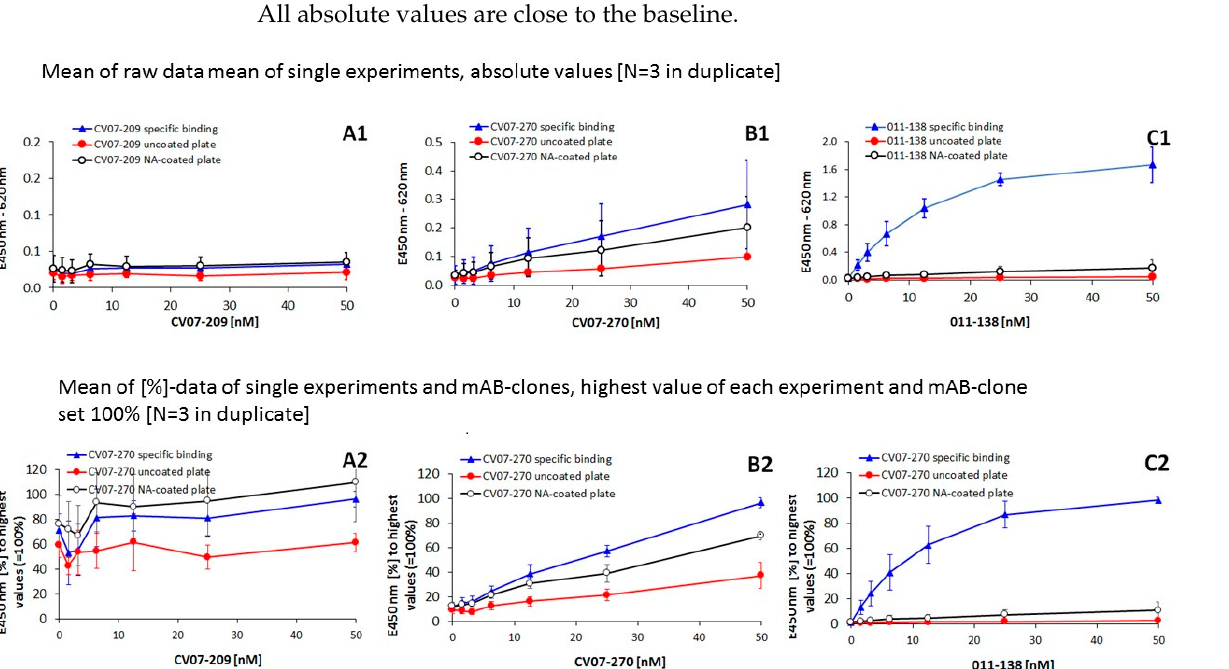
Figure 2. CD spectroscopic evaluation of the molecular interaction of BC 007 with sequence sections of the CDR-H3 regions of anti-SARS-CoV-2 antibodies. The BC 007 (21.5 µM) folding success in presence of no peptides (control, black curves) and increasing concentrations of peptides ( A ) AR- ARGSSGWYRIGTRWGNWFDP (source: CV07-270, PDB ID 6XKP), ( B ) ARDGVIPPRFDY (source: CV07-209 of [21] ) and ( C ) AGSDNYGFPYNGMDV (source: CV-250, PDB ID: 6XKQ) up to a molar excess as indicated by the color of the curve was measured. Green, red, and blue curves show the BC 007 spectra with additional presence of 6.25, 12.6, and 25.0 µM peptide, respectively.